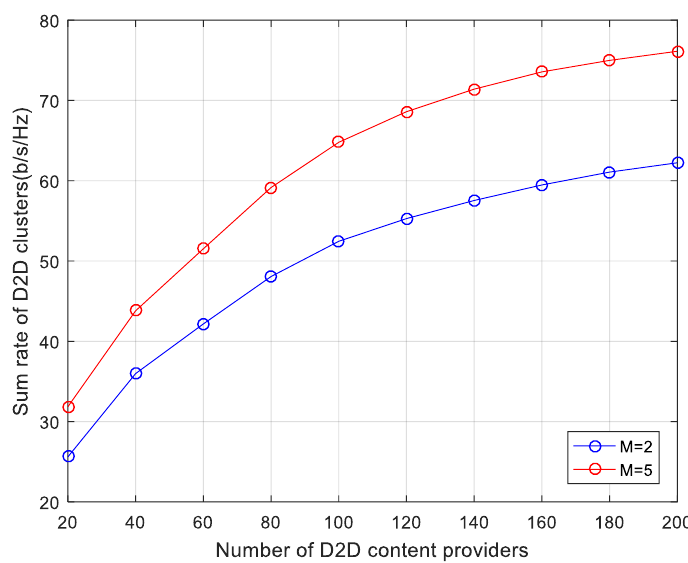
Figure 7. Sum rate of D2D clusters for di ff erent numbers of cellular channels with di ff erent numbers of D2D content providers, N = 5.